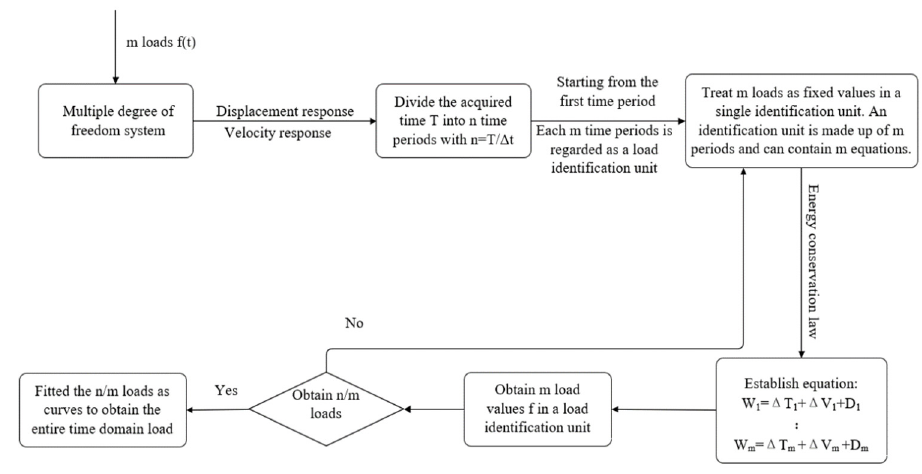
Figure 4. Multi-load identification of multi-DOF system.